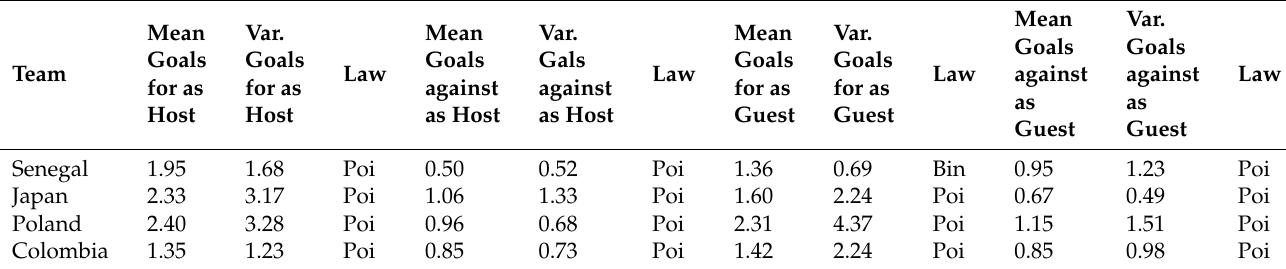
Table 13. Group H in Russia